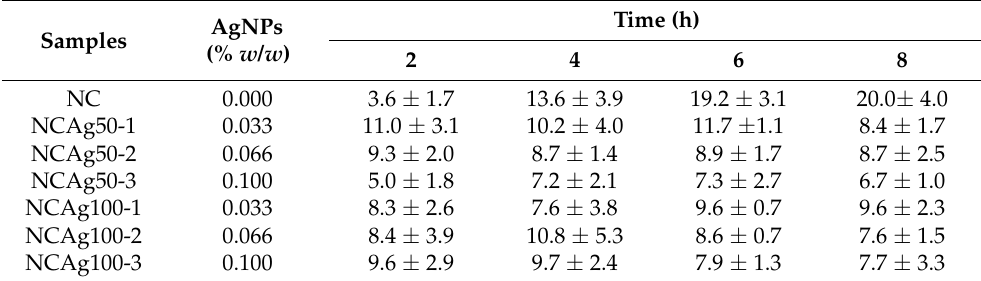
Table 3. Percentage of toluene uptake of NC, NCAg50, and NCAg100 after the immersion for 2, 4, 6, and 8 h in toluene. The data were the average values determined from three specimens ( n = 3).